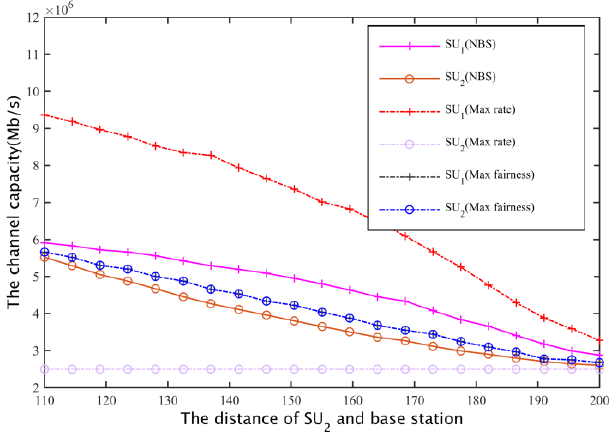
Figure 20. Secondary user channel capacity comparison I.